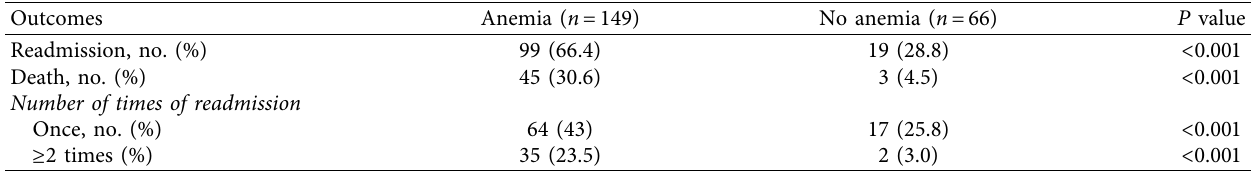
Table 2: Readmission and death within 1 year of discharge: Analysis of the study